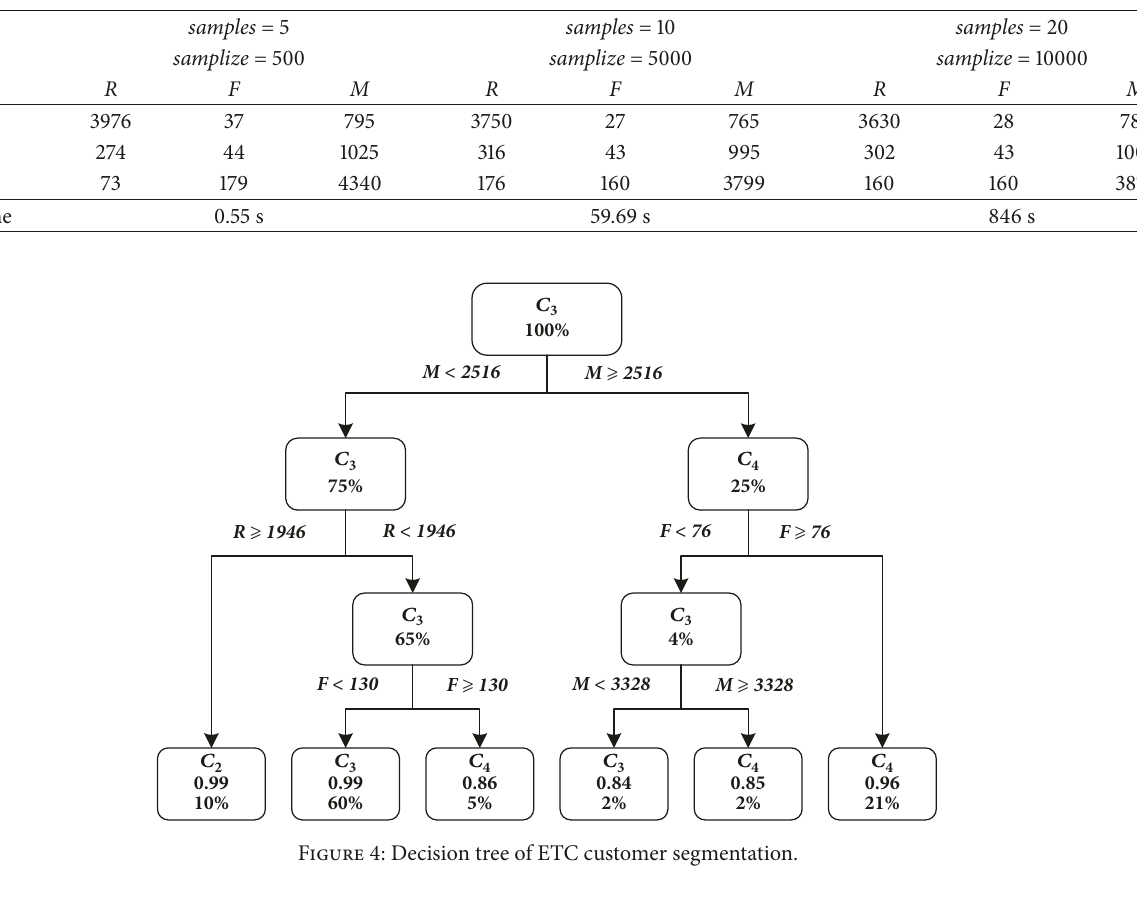
Table 4: Calculation results of clustering medoids under different combined parameters.